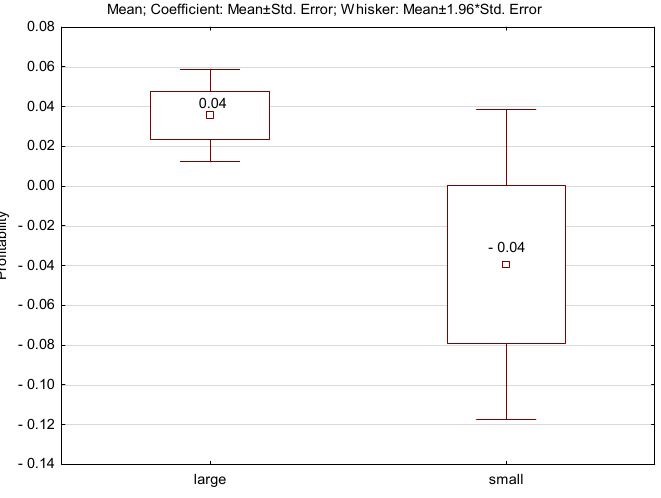
Figure 6. Profitability by company in 2017.